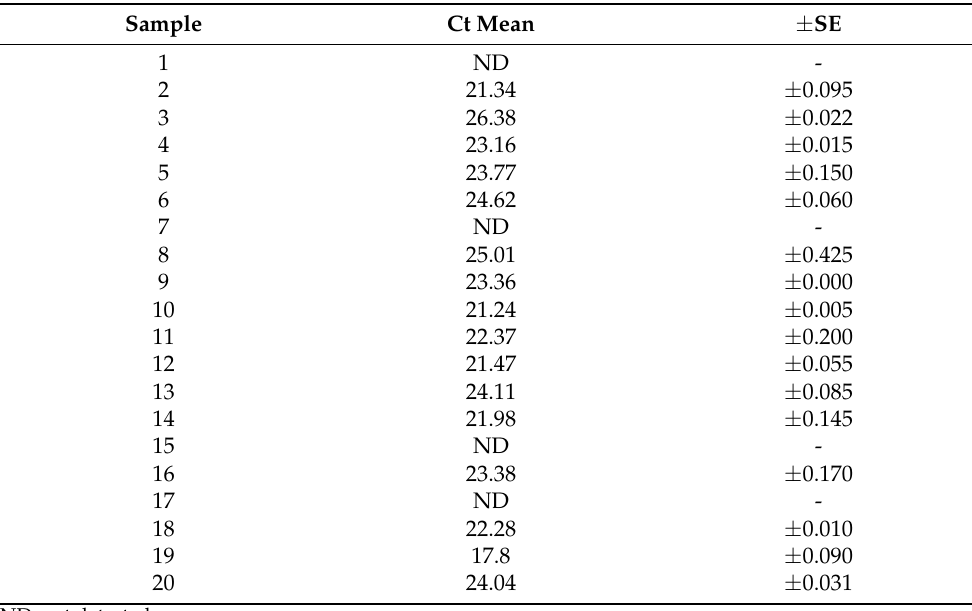
Table 3. Mean threshold cycle values (Ct) and standard error ( ± SE) of tomato sampled plants infected with Fusarium spp. Transcript levels were determined by